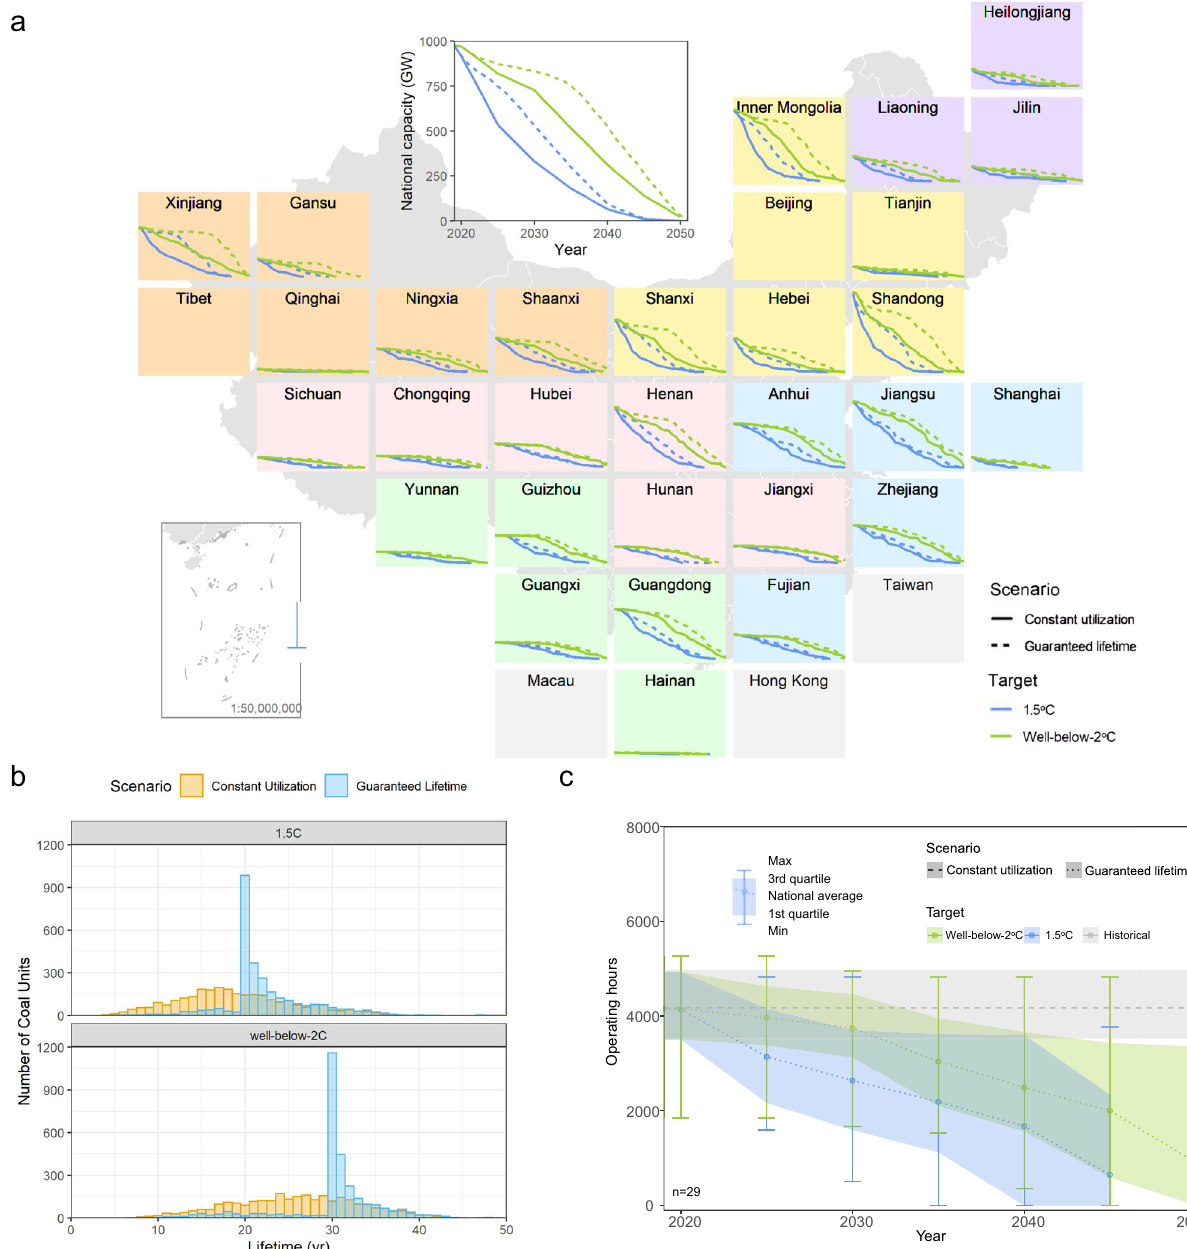
Fig. 4 National and provincial coal phaseout pathways and implications on coal plants ’ operational lifetimes and utilization levels under two different strategies. a Coal plants retirement pathways under the constant utilization scenario (solid line) and the guaranteed lifetime scenario (dashed line), under 1.5 °C (blue) and 2 °C (green), respectively. Compared to the constant utilization scenario, national retirement pathways are delayed by about 5 years the guaranteed lifetime scenario; regional impact varies largely across provinces. b Distribution of operational lifetimes of coal plants under the constant utilization scenario (yellow bars) and the guaranteed lifetime scenario (blue bars), under 1.5 °C (top panel) and 2 °C (bottom panel), respectively. c Range of plant operating hours under the constant utilization scenario (gray area) under both climate targets, and the guaranteed lifetime scenario under 1.5 °C (blue area) and 2 °C (green area), respectively. The bars indicate the full range of minimum to maximum values across provinces, and the areas indicate the fi rst to third quartile. National average is indicated by the lines. Due to the delayed retirement of coal plants, remaining capacity must operate at gradually reduced